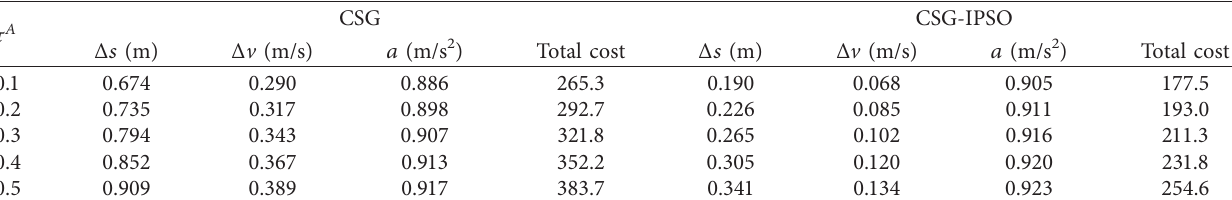
Table 6: Sensitivity analysis of actuator lag of CSG and